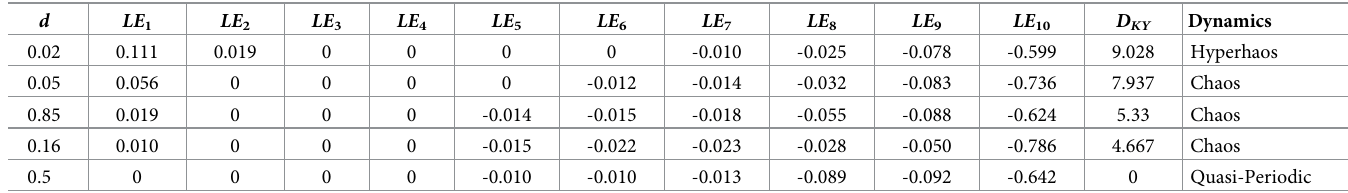
Table 5. Lyapunov exponents, Kaplan-Yorke dimension and dynamics of the new 10-D hyperchaotic system (1) with parameter d varying.